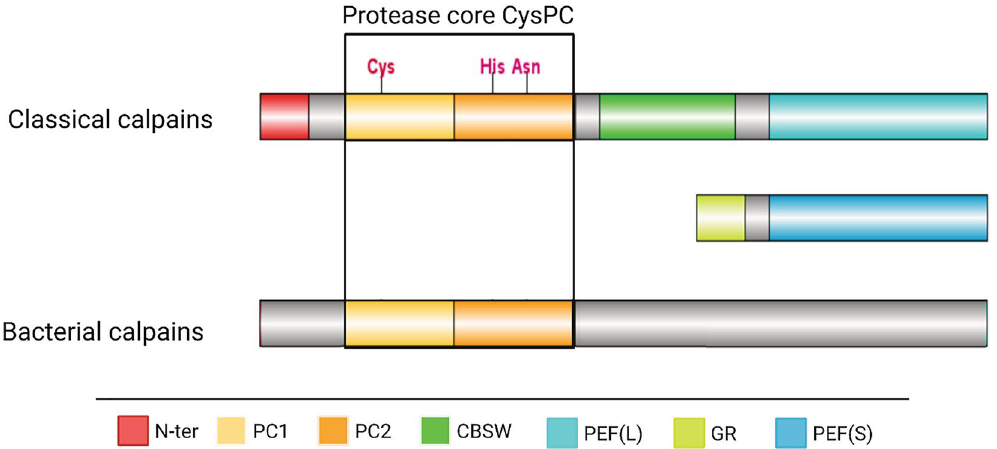
Figure 1. Structural comparison of classical and non-classical calpains. Classical eukaryotic calpains are heterodimers composed of large and small subunits. Each subunit is composed of conserved domains.